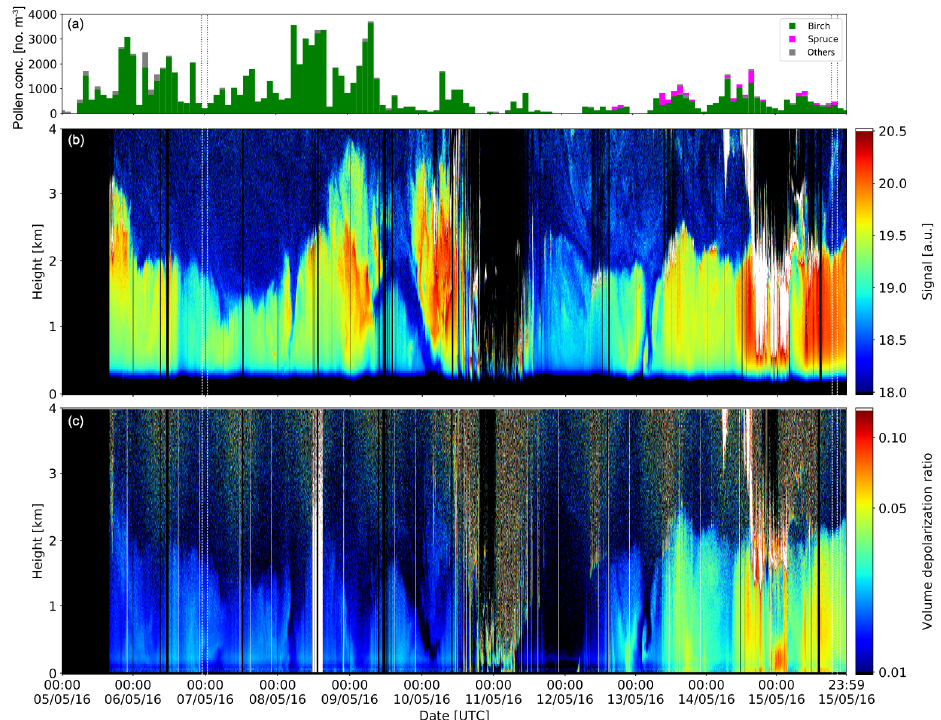
Figure 1. Overview of the 11d birch pollen period. (a) Pollen concentration obtained from the Hirst-type pollen sampler, (b) range-corrected signal at 1064nm and (c) volume depolarization ratio at 532nm. Dashed vertical lines mark the period of the case studies.